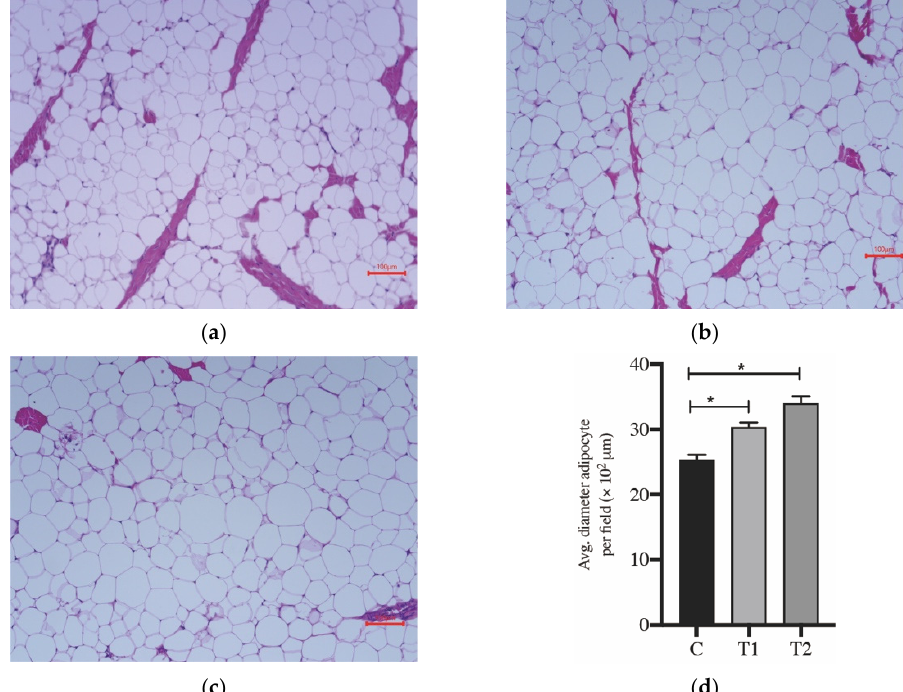
Figure 2. Representative H&E staining of white adipose tissue. The results of hematoxylin-eosin staining of pig dorsal white adipose tissue in groups C ( a ), T1 ( b ) and T2 ( c ) are shown in the figure; the adipocyte diameter was the largest in group T2, followed by group T1, and was the smallest in group C. The findings of the statistical analysis revealed that there were significant differences between the groups ( d ) ( p < 0.05). Statistical data were given as mean ± standard error, n = 8. Significance was calculated using one-way ANOVA and Tukey’s post hoc test. Diets with black soldier fly treatments have distinct bars with various letters ( p < 0.05). Each scale bar is 100 μ m long. * Indicates that there is a significant difference between the different treatment groups ( p < 0.05).